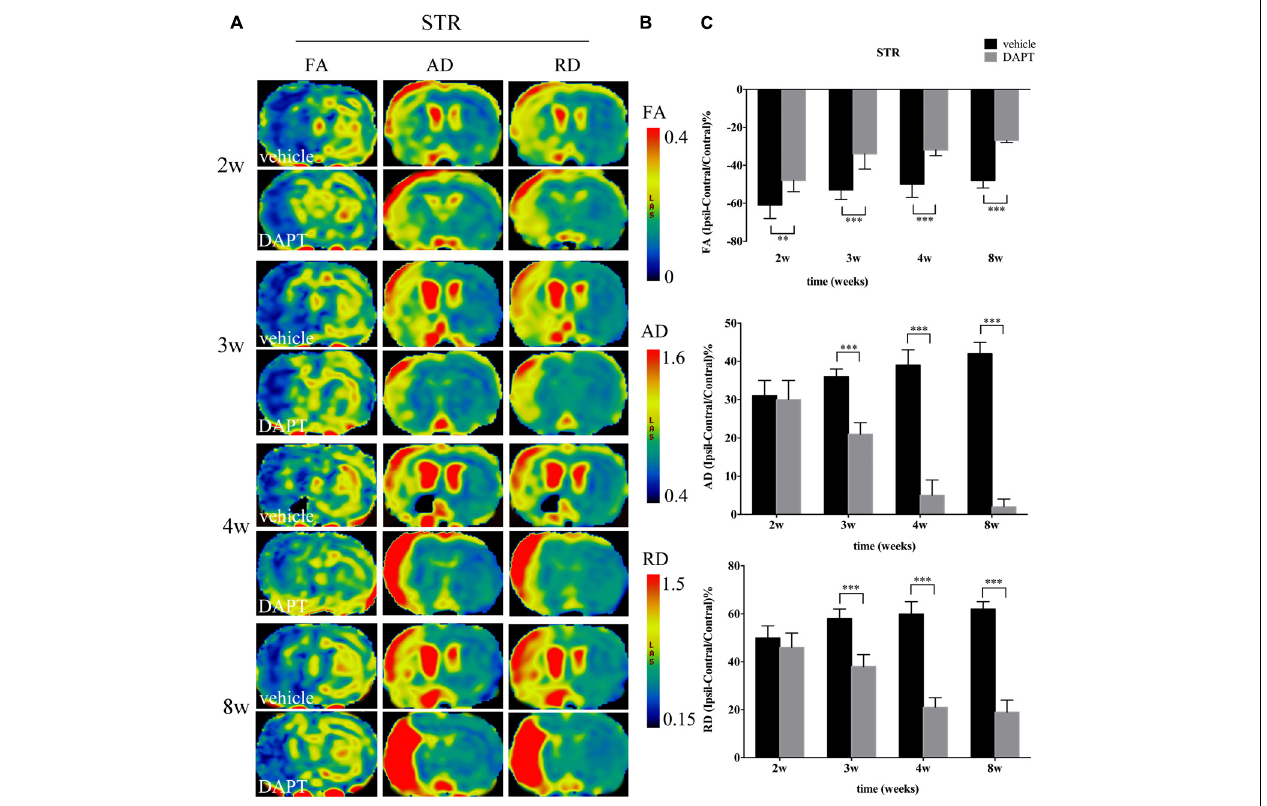
FIGURE 5 | Effects of DAPT on microstructure changes of ischemic boundary of STR with DTI maps after MCAO. (A) The evolution changes in FA, AD and RD of ipsilateral STR in DAPT-treated rats and vehicle rats from 2 to 8w. (B) The range of FA, AD, and RD. (C) Comparisons of FA, AD, and RD of ischemic boundary of STR between two group rats. FA: ∗∗ P < 0.01, 2w; ∗∗∗ P < 0.001, 3w, 4w, 8w versus DAPT and vehicle. AD, RD: ∗∗∗ P < 0.001, 3w, 4w, 8w versus DAPT and